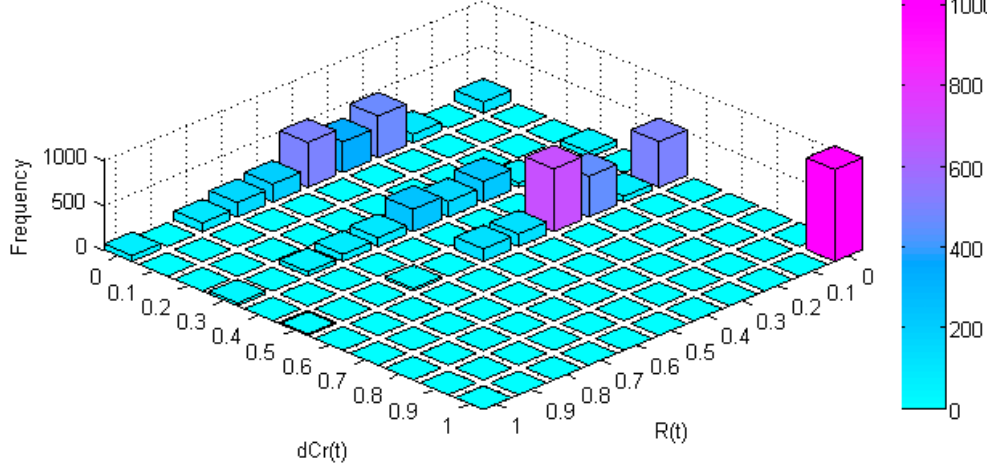
Figure 11. Number of routes passing through each node in a 3 × 3 PWMNS.